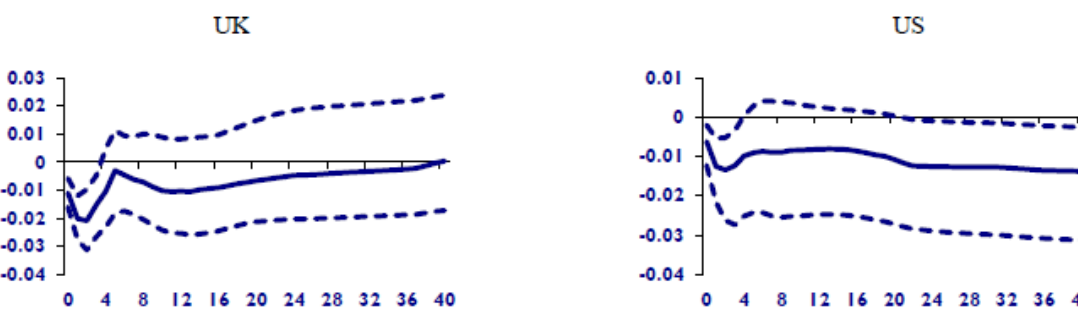
Figure 1. GVAR-based oil price uncertainty shocks and real stock prices ( country-level ). Note: The figure depicts the country-specific impulse response functions of real stock prices to a one standard deviation increase in oil price uncertainty. The median impulse response is presented in solid lines, while the 16–84% lower and upper bootstrapped error bands are shown in dotted lines. The impact is measured in percentage points (by multiplying the estimates in the figure with 100) over the quarterly horizon.